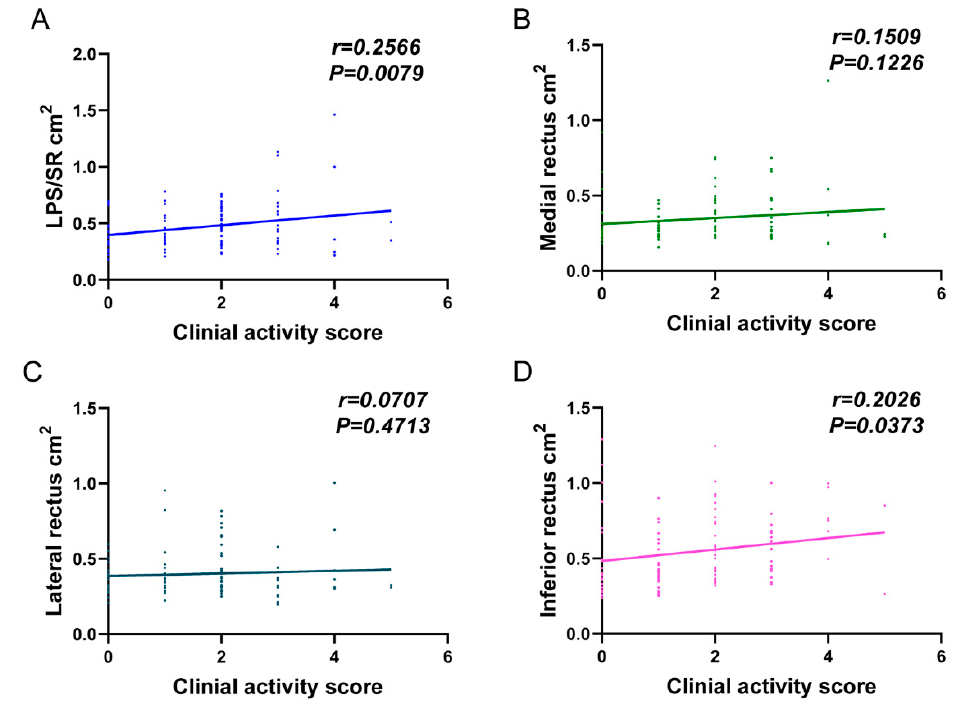
Figure 4. Linear regression analysis of the changes in clinical activity scores and the largest cross- sectional area of extraocular muscles. ( A ) LPS/SR; ( B ) Medial rectus; ( C ) Lateral rectus; ( D ) Inferior rectus) in 53 TAO patients. IOP, intraocular pressure; MRD1, margin re fl ex distance to the upper eyelid; MRD2, margin re fl ex distance to the lower eyelid; LPS/SR, levator palpebrae superioris–superior rectus complex.